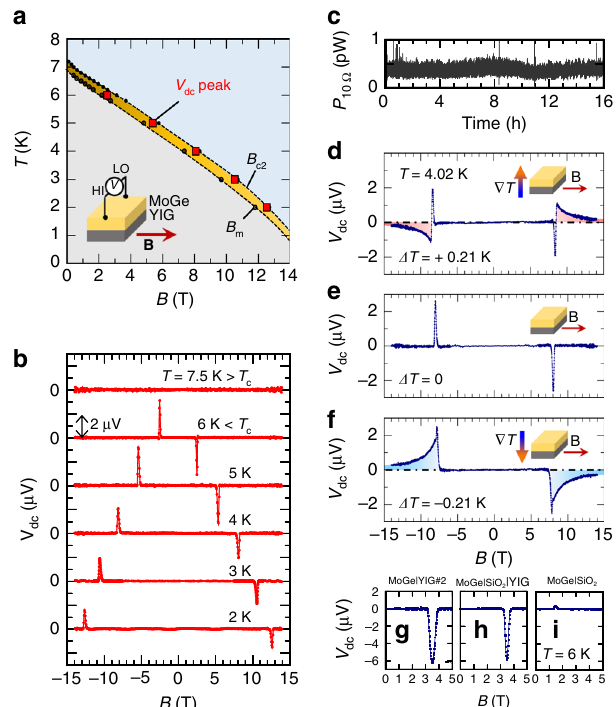
Fig. 3 D.c. voltage generation observed in MoGe|YIG. a D.c. voltage V dc peak in the B – T phase diagram of MoGe. The inset shows the measurement setup. The direction of the magnetic fi eld is almost parallel to the sample surface. b Magnetic fi eld dependence of the d.c. voltage generated in the MoGe layer at selected temperatures. The length of the scale bar is 2 μ V. c Temporal evolution of the generated power P 10 Ω in a constant magnetic fi eld ( T = 6 K, B = 2.5 T, with the magnet in persistent mode). P 10 Ω was measured on a 10 Ω resistor connected parallel to the sample. d – f Magnetic fi eld dependence of d.c. voltages in a MoGe|YIG sample for positive, zero, and negative temperature difference, respectively, between the top and the bottom of the sample at T = 4 K. D.c. voltage generated in g MoGe|YIG sample #2, h MoGe|SiO 2 (10 nm)|YIG, and i MoGe|SiO 2 at T = 6